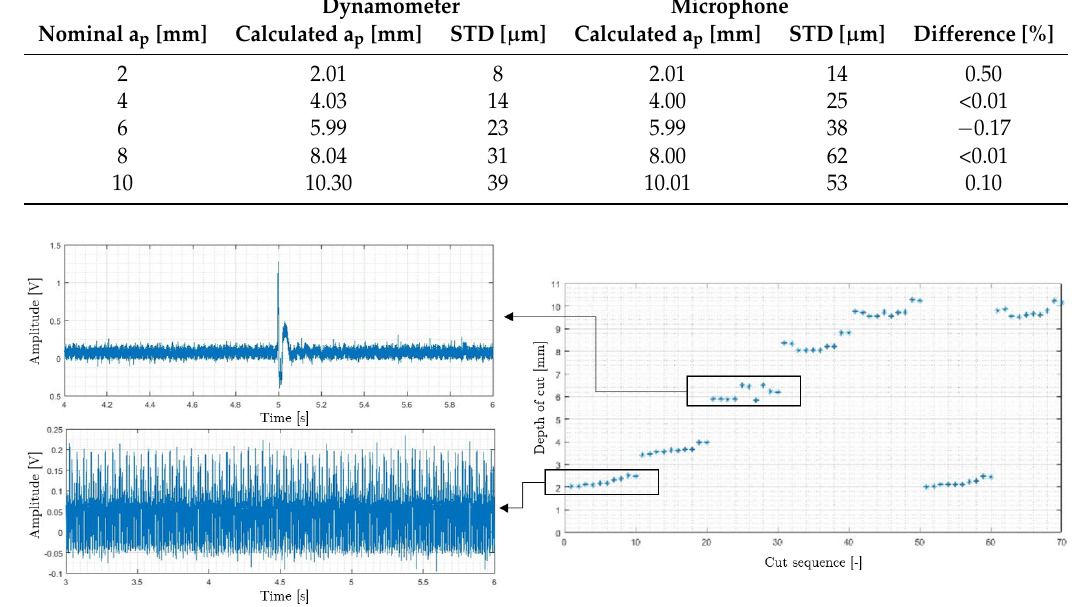
Figure 10. Effect of impacts and high level of background noise on the experimental